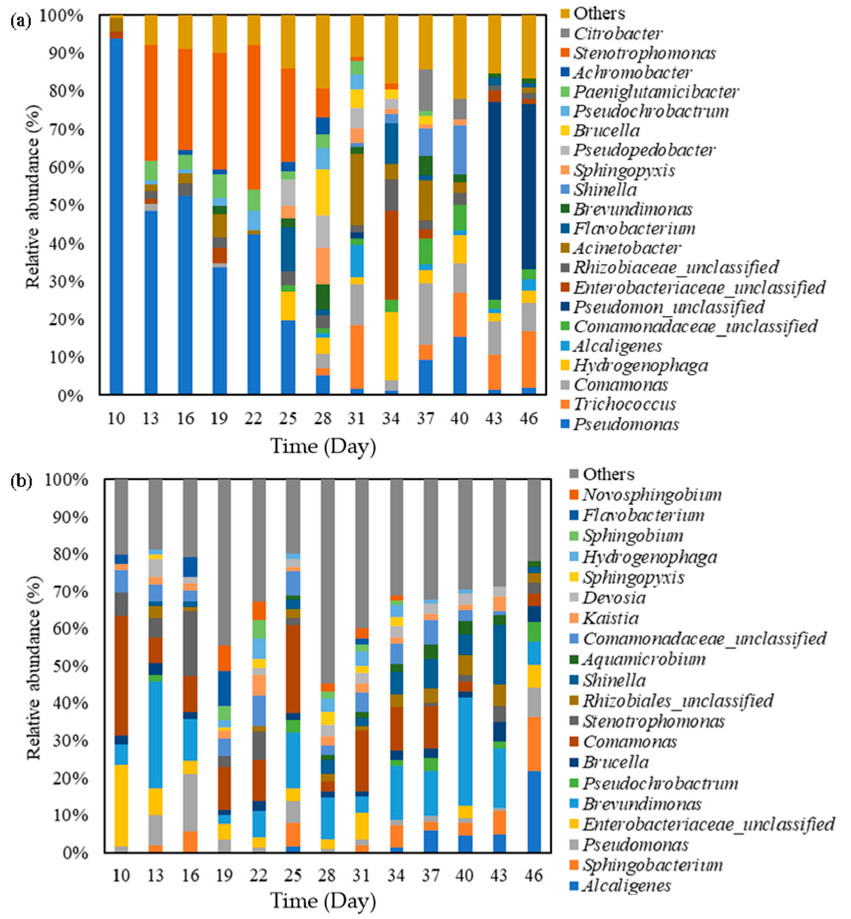
Figure 6. Bacterial community composition of the BTF1 ( a ) and BTF2 ( b ) at genus level, others represent microbial species with relative abundance <1%. The major predominant bacteria in the composite filler BTF included Pseudomonas, Stenotrophomonas , Comamonas , Trichococcus , Acinetobacter , and Hydrogenophaga (Figure 6a), with the average relative abundances of 25.1%, 12.4%, 4.6%, 4.5%, 4.0%, and 3.7%, respec- tively. The relative abundance of Pseudomonas gradually decreased with the operation of the BTF (93.7% at the end of the startup phase vs. 1.9% at the end of the operation). Sten- otrophomonas mainly existed in stage II, with the highest abundance being 38.2% (22 d). Comamonas , Trichococcus , and Hydrogenophaga mainly existed in stage III, with the highest abundances being 16.0% (37 d), 16.63% (31 d), and 18.1% (34 d), respectively. The predominant bacterial genera in the bark filler BTF were scattered. The major predominant bacterial genera included Brevundimonas , Comamonas , Enterobacteriaceae_un- classified , Comamonadaceae_unclassified , Pseudomonas , and Stenotrophomonas (Figure 6b), with relative abundances of 12.8%, 11.1%, 4.8%, 4.4%, 4.0%, and 3.99%, respectively. Among them, Brevundimonas was the first predominant bacterium, and its maximum abundance was 29.37%, which was lower than the maximum abundance of Pseudomonas (the first predominant bacterium in the composite filler BTF) of 93.7%. Comamonas , Pseu- domonas , and Stenotrophomonas were also the predominant bacterial genera in the compo- site filler BTF, and their corresponding relative abundances in the bark filler BTF ranged